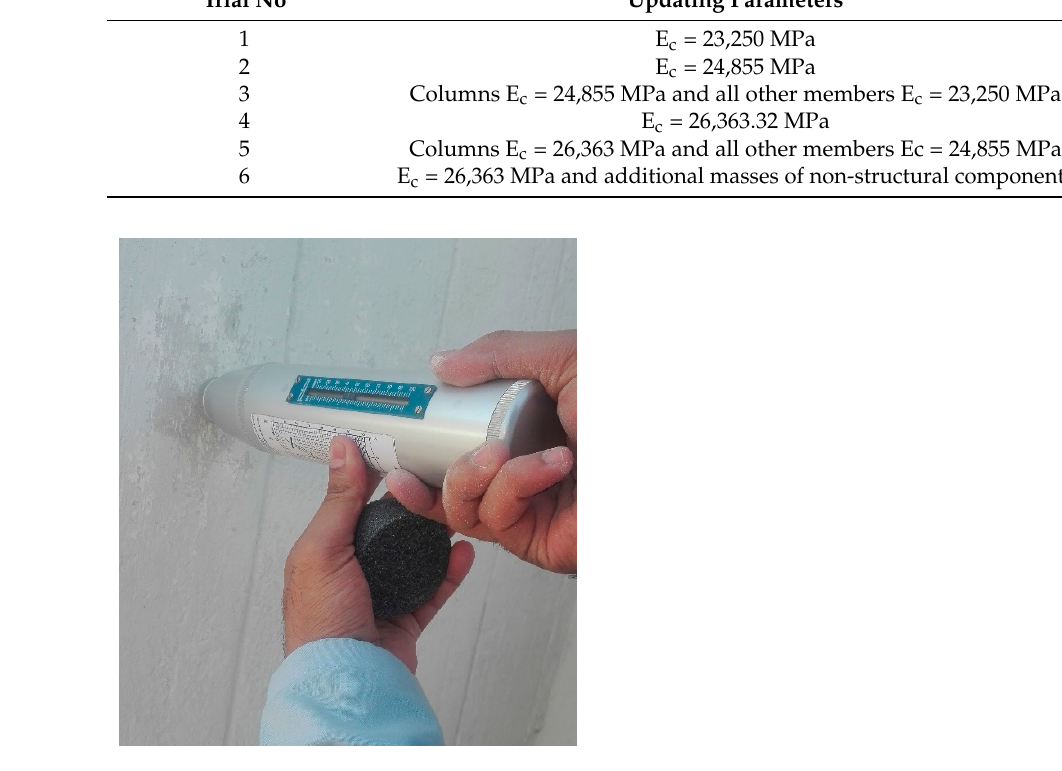
Figure 13. Rebound hammer test. Table 5. Manual model updating